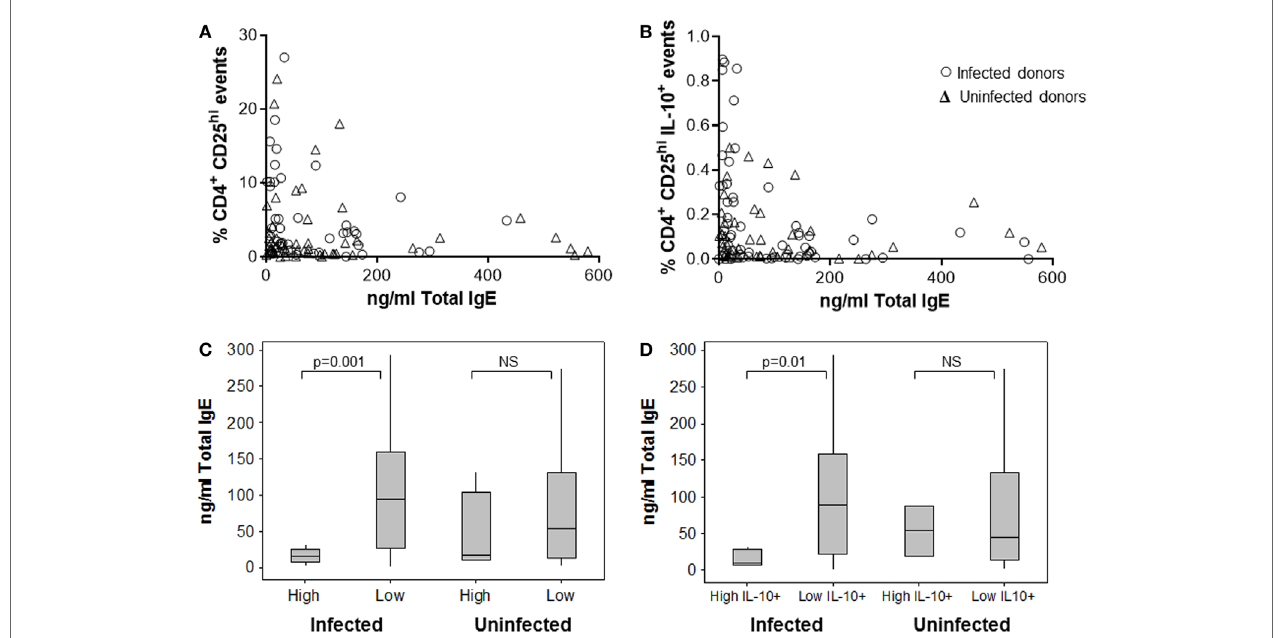
FigUre 5 | association between human peripheral blood regulatory T-cells and the ige response . The frequency of CD4 + CD25 hi (a) and IL-10 + CD4 + CD25 hi Tregs (B) in PBMCs from 49 infected and 46 uninfected donors was assessed by flow cytometry after 15 h culture with Hp lysate antigen. This was compared to the total plasma IgE concentration for each patient. The data were divided according to whether there were high ( > 10%) or low frequencies of CD4 + CD25 hi lymphocytes (c) and high ( > 0.4%) or low frequencies of IL-10 + CD4 + CD25 hi events (D) to further examine associations with total IgE concentrations. NS = no significant difference.